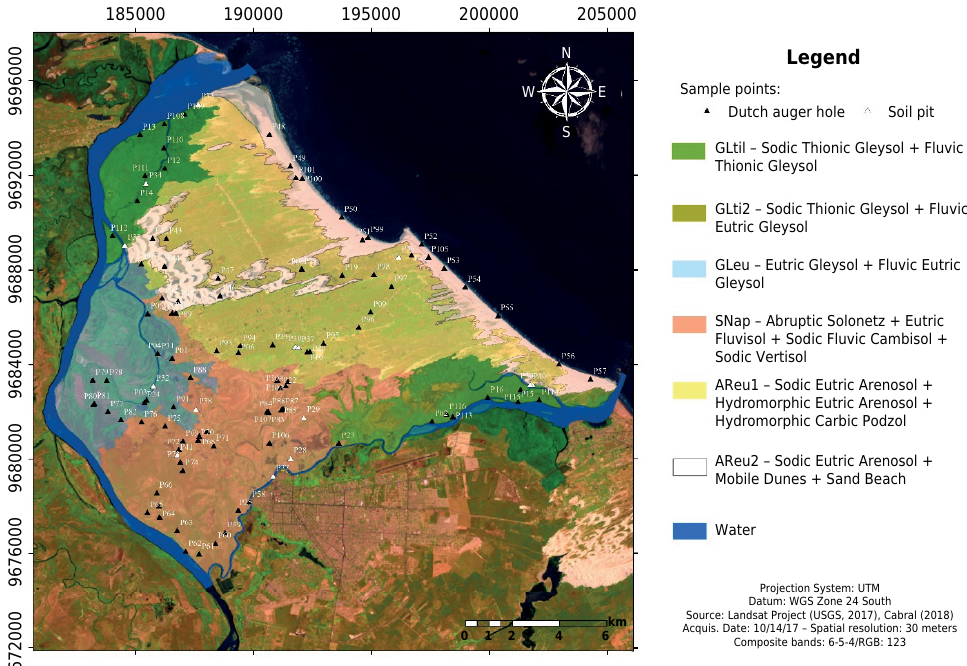
Figure 2. Location of soil sampling points. Source: Adapted from Cabral